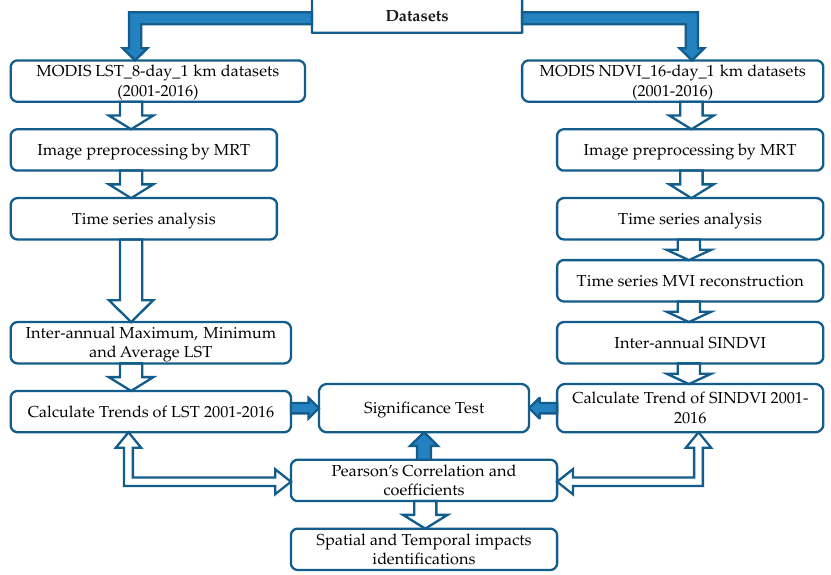
Figure 3. Data processing and analysis flowchart.